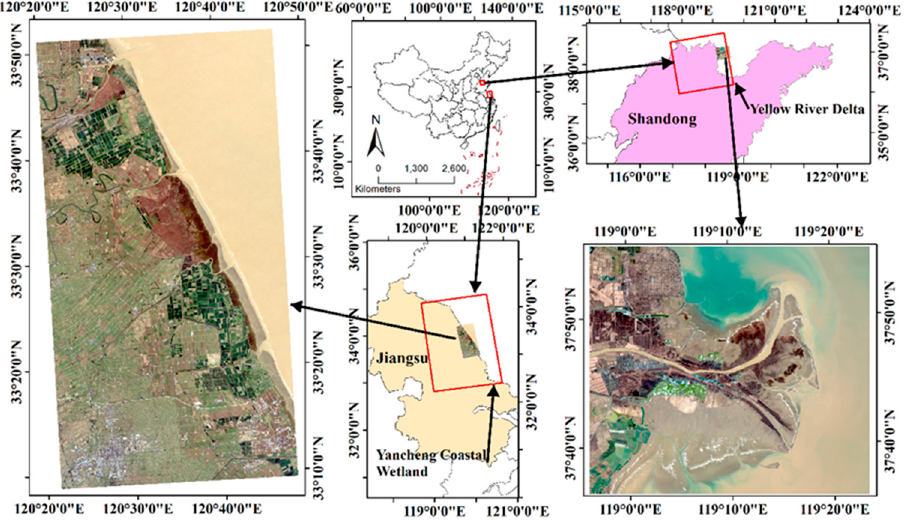
Figure 1. Location of our study areas.